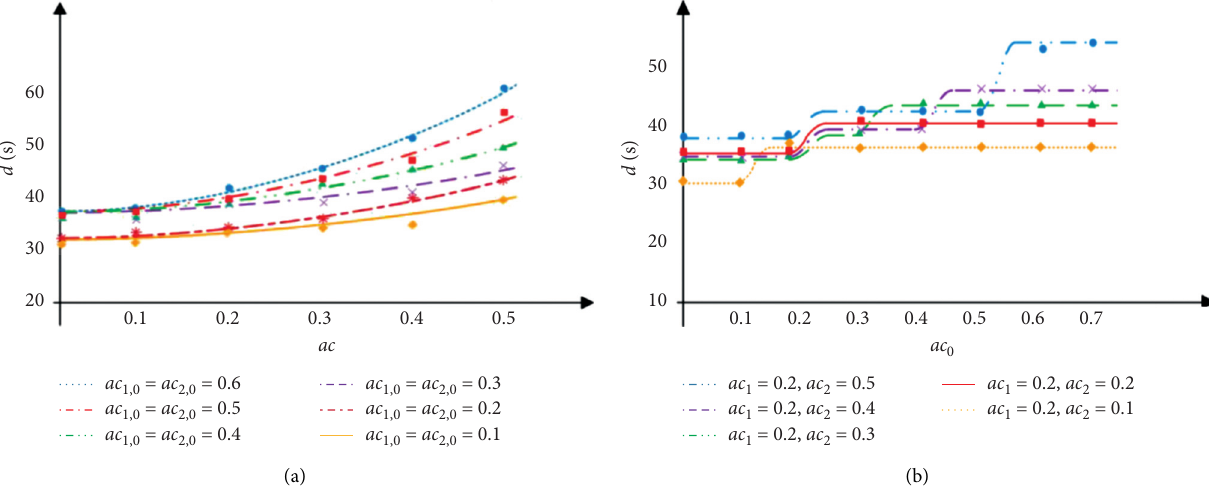
Figure 8: Asymmetric coefficient threshold on the phase delay. (a) Variation of phase delay with the asymmetric coefficient under different thresholds. (b) Variation of phase delay with threshold under different asymmetric